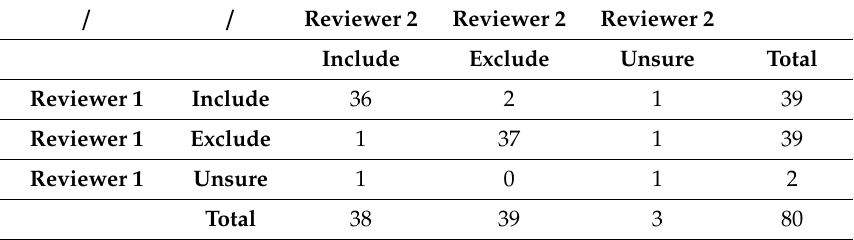
Table 2. K agreement calculation: Po = 0.925 (proportion of agreement) and Pe = 0.4701 (agreement expected), and so K agreement = 0.8584. No agreement, 0.0–0.20: slight agreement, 0.21–0.40: